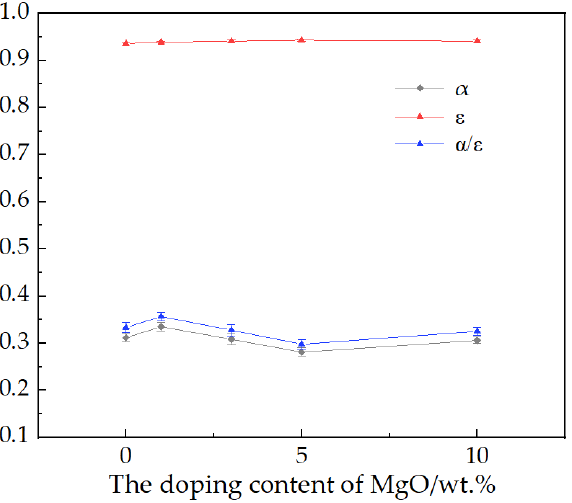
Figure 8. α/ε values of the Al 2 O 3 coatings with different MgO doping contents. Figure 8. α / ε values of the Al 2 O 3 coatings with different MgO doping